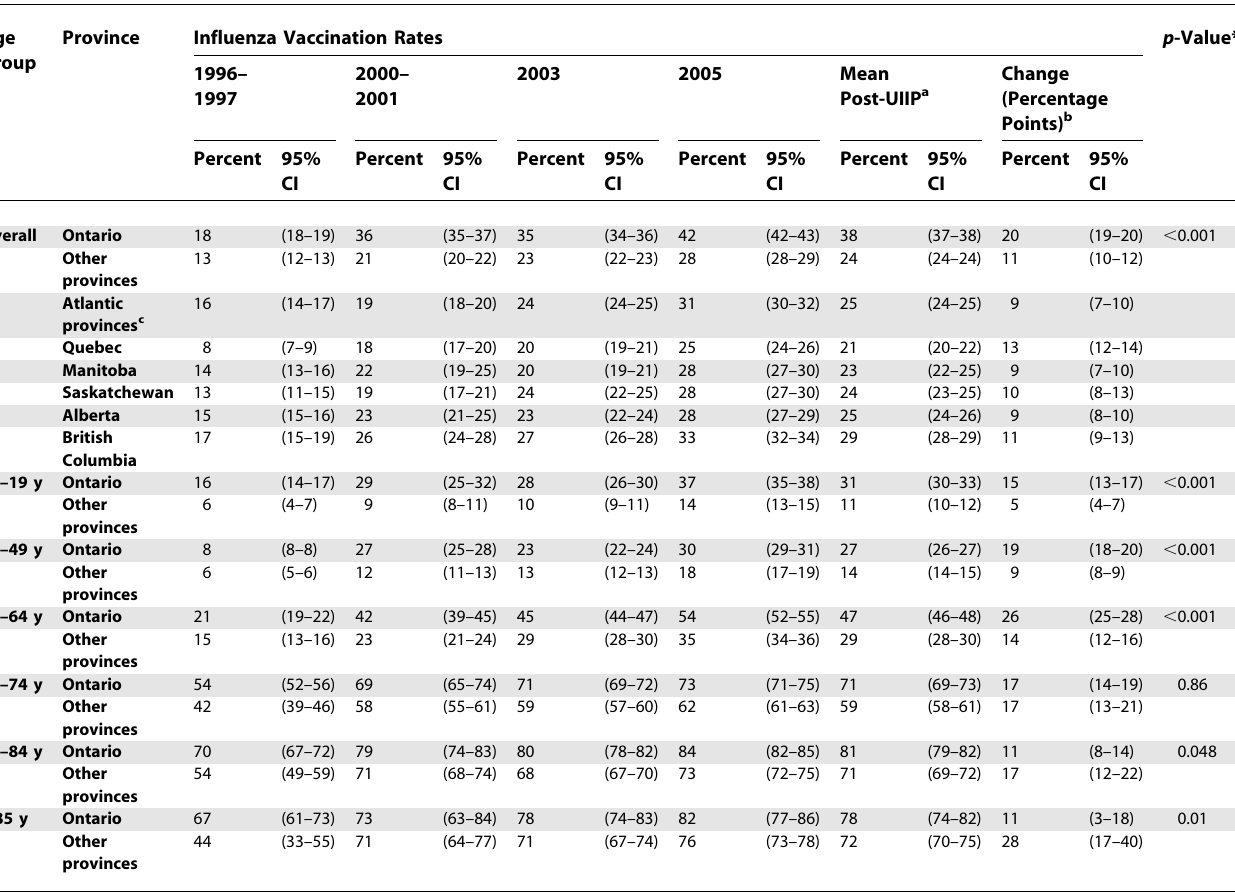
Table 2. Influenza Vaccination Rates over Time for Ontario and Other